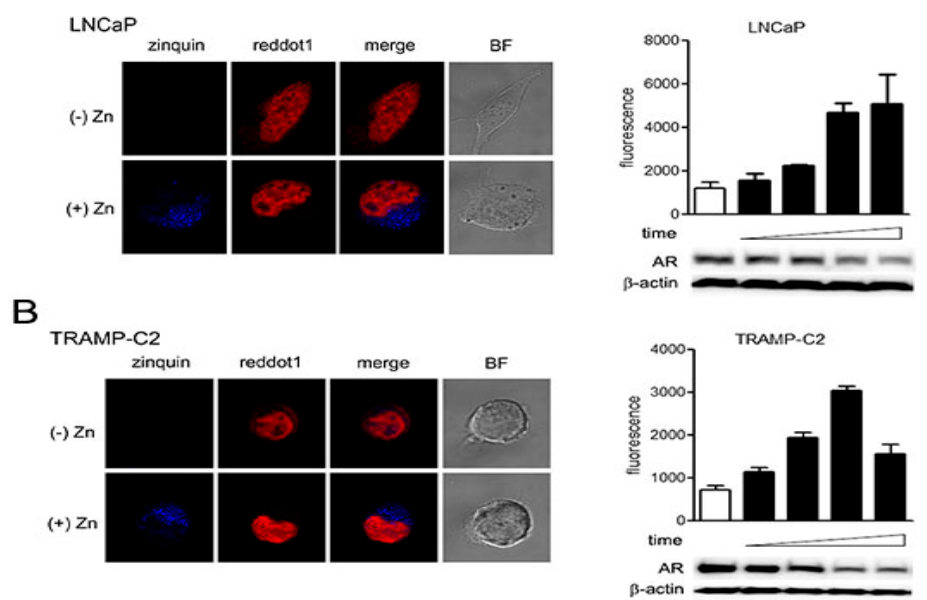
Figure 4. Exogenous zinc is primarily localized to the cytoplasm. ( A , B ) (left panels) Cells were seeded in 4-well chambers to reach 60% confluence, then treated with zinc at 150 µM (LNCaP) or 75 µM (TRAMP-C2) for 6 h. Cells were then treated with 20 µM zinquin and incubated for 30 min at 37 °C. Cells were washed and treated with RedDot1 and observed by confocal microscopy. ( A , B ) (right panels) Fluorescence intensities were measured at 0, 1, 2, 4, and 6 h and are expressed as mean ± SD. Cells monitored by confocal microscopy were also used for protein analysis.